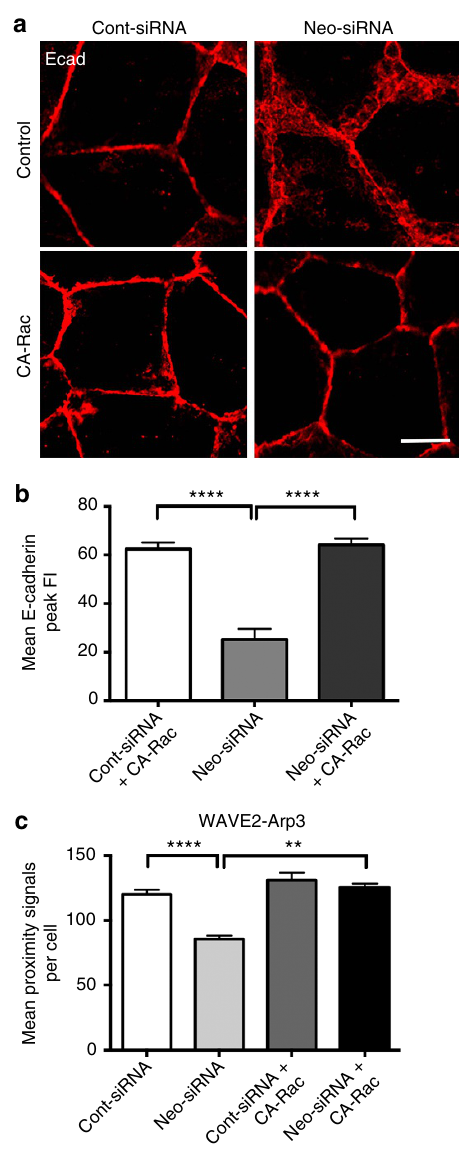
Figure 6 | Neogenin requires Rac activation to promote WAVE2–Arp2/3 interactions. ( a ) Cotransfection of CA-Rac with Neo-siRNA rescued junctional integrity. ( b ) Line-scan analysis: mean Ecad peak fluorescence intensity (FI) in cells coexpressing Neo-siRNA and CA-Rac ( n ¼ 150 junctions, mean ± s.e.m., **** P o 0.0001, one-way analysis of variance (ANOVA), Dunn’s post hoc test). ( c ) The Duolink proximity assay revealed that WAVE2 associated with Arp3 in cells cotransfected with CA-Rac and Neo-siRNA, but not with Neo-siRNA alone ( n ¼ 3 experiments, mean ± s.e.m., ** P o 0.01, **** P o 0.0001, one-way ANOVA, Dunn’s post hoc test). Scale bar, 15 m m ( a